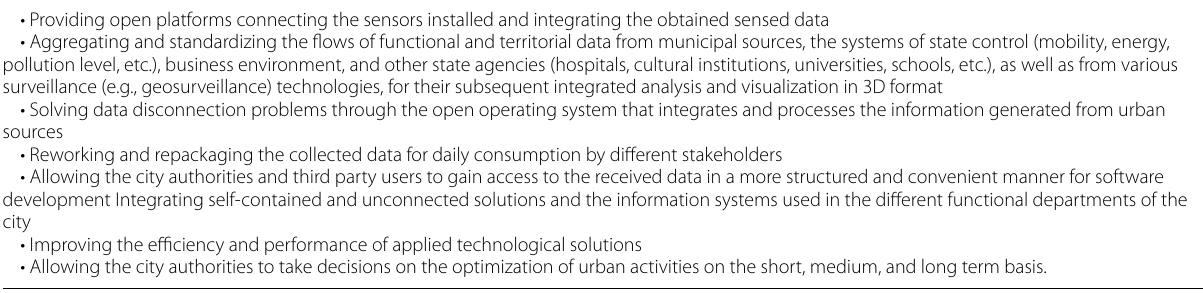
Table 1 The key functions of the horizontal information system for data-driven smart cities